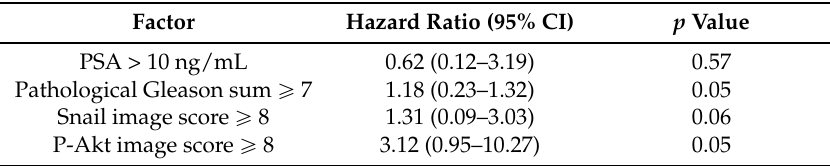
Table 3. Survival analyses of biochemical progression predictors in patients with prostate cancer at pT2 who underwent a radical prostatectomy (RP) according to a Cox proportional hazards regression model.